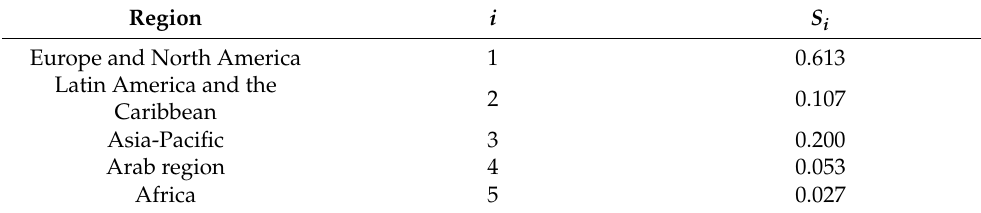
Table 4. Value of the Gini coefficient parameter.